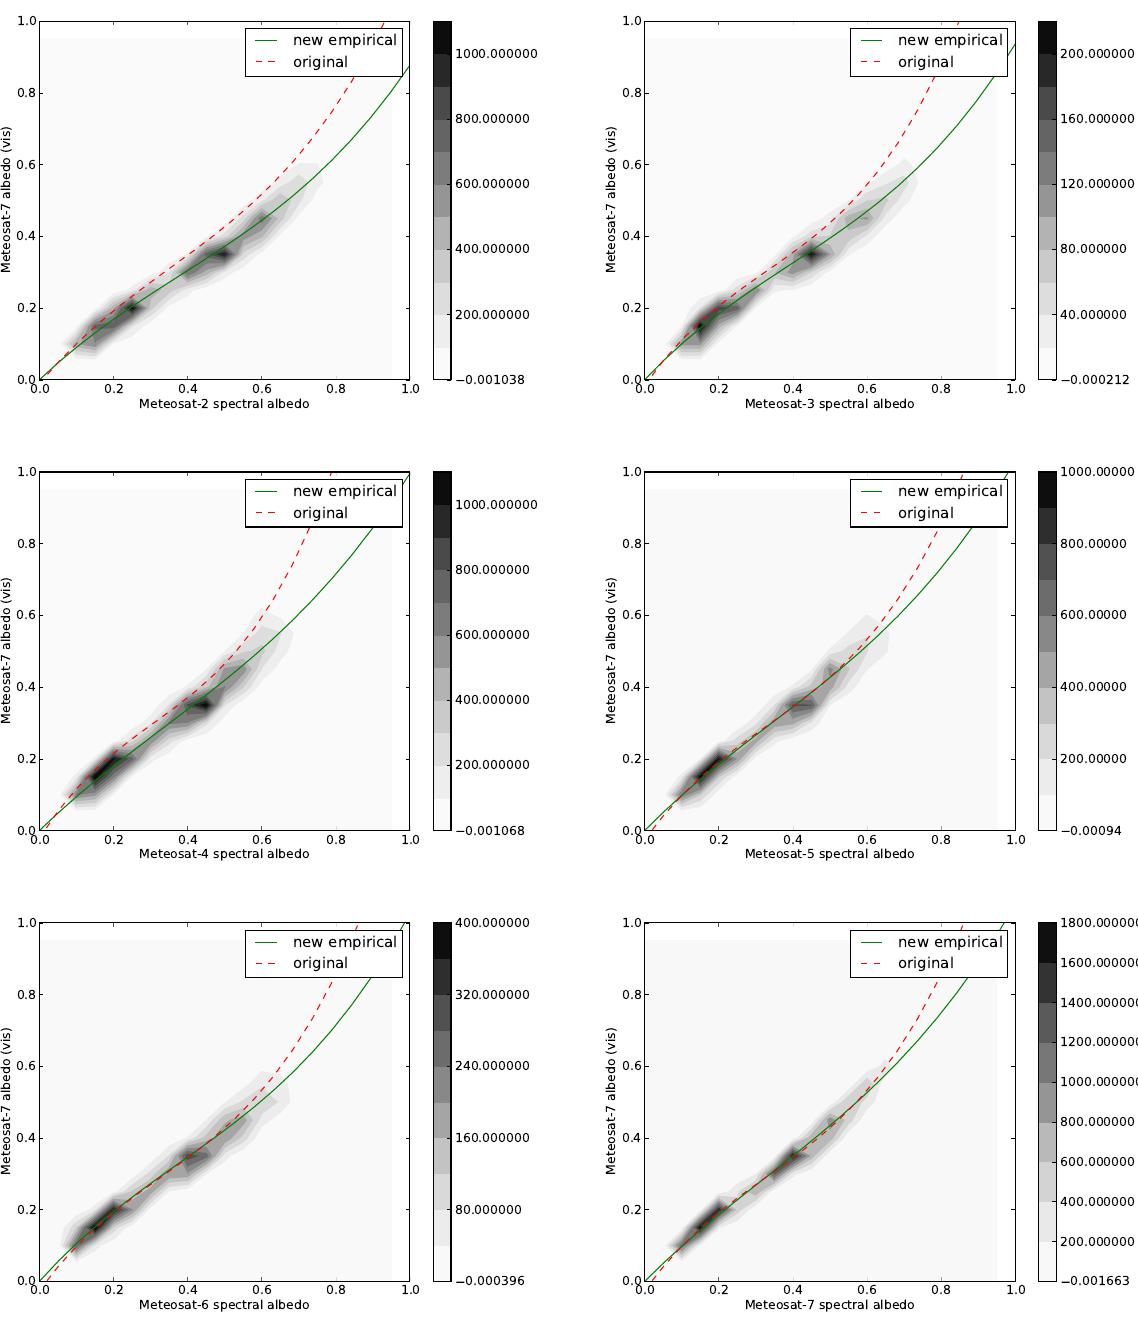
Figure 4. Density plot of the relationship between BHR VIS band for all Meteosat satellites. The red dashed line corresponds to the theoretical relationship as given in the product user manual [18] and the green solid line corresponds to the new empirically estimated relationship. While strong corrections are applied for the Met-2/3-4 sensors, the curves for Met-5/6/7 are nearly identical for the albedo range 0 . . . 0 . 6